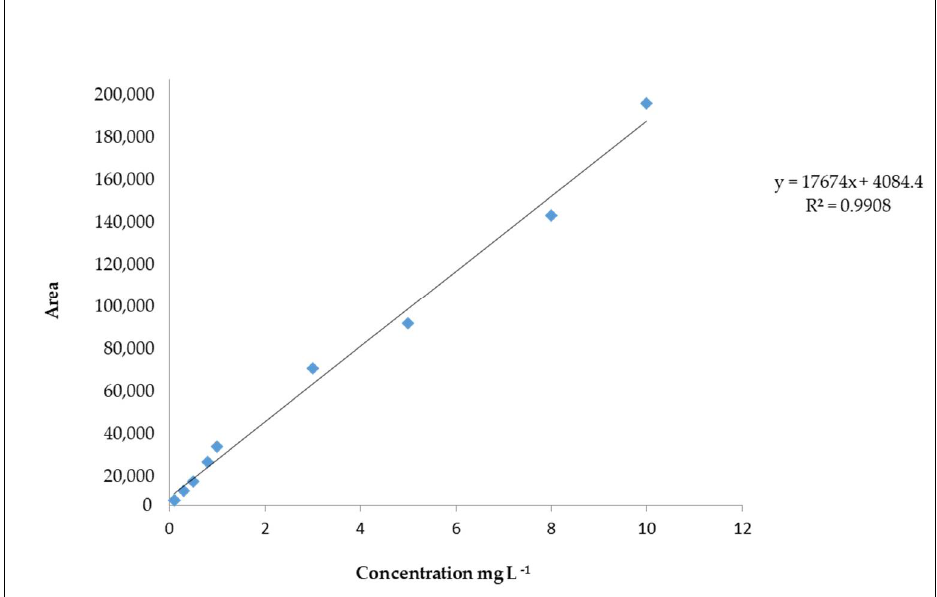
Figure 2. Calibration curve of 4(5)-MEI.